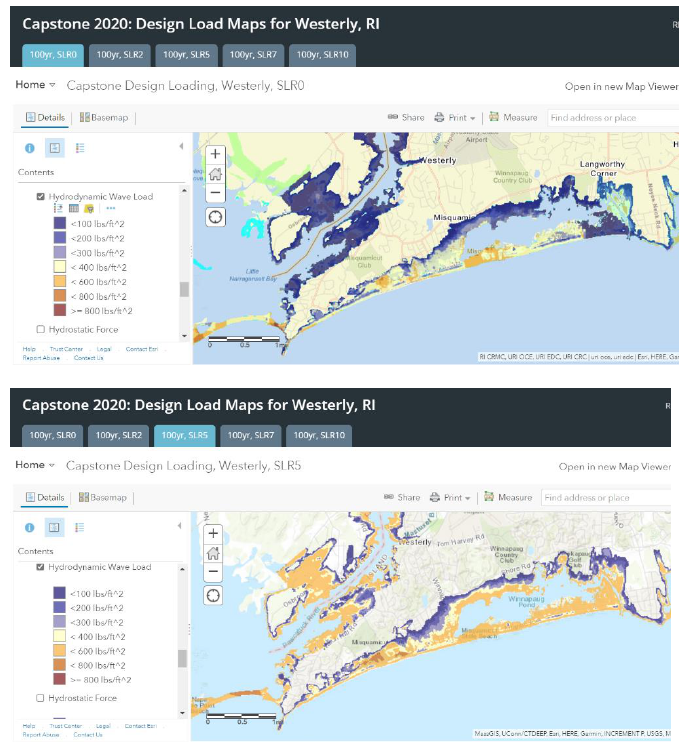
Figure 11. Hydrodynamic wave loading (lbs/ft 2 ), 100 yr storm, 0 ft sea level rise ( upper panel), 5 ft SLR ( lower panel). J. Mar. Sci. Eng. 2021 , 9 , x FOR PEER REVIEW